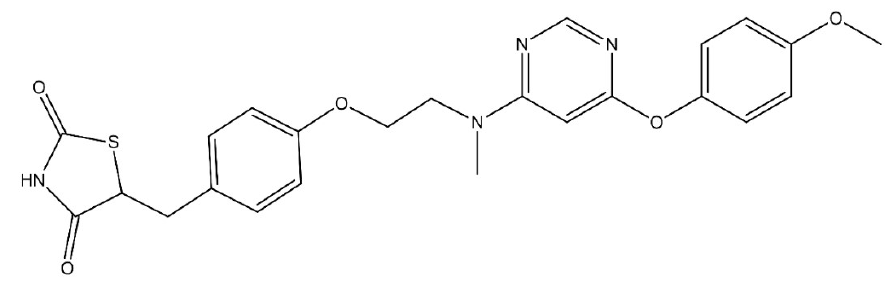
Figure 1. The molecular structure of lobeglitazone (LOBE).